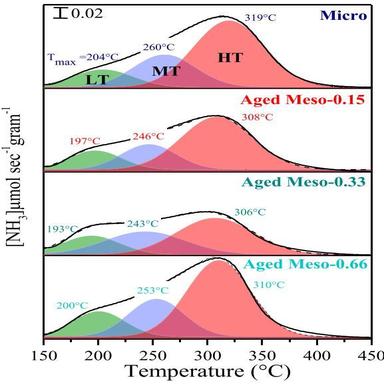
NH3-TPD profiles of Micro and hierarchical Aged Meso-0.15, Aged Meso-0.33 and Aged Meso-0.66 SAPO-34 zeolites with the corresponding deconvoluted peaks at LT, MT and HT.